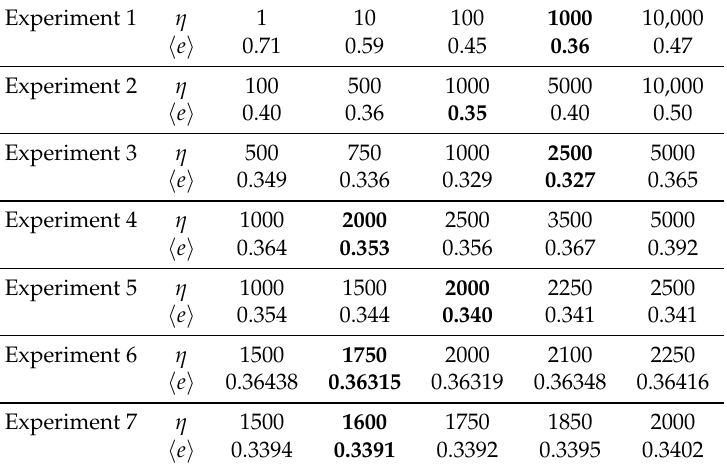
Table A4. Results of the experiments to identify the almost optimum value of η giving the smallest (cid:104) e (cid:105) when Correlation is Ignored